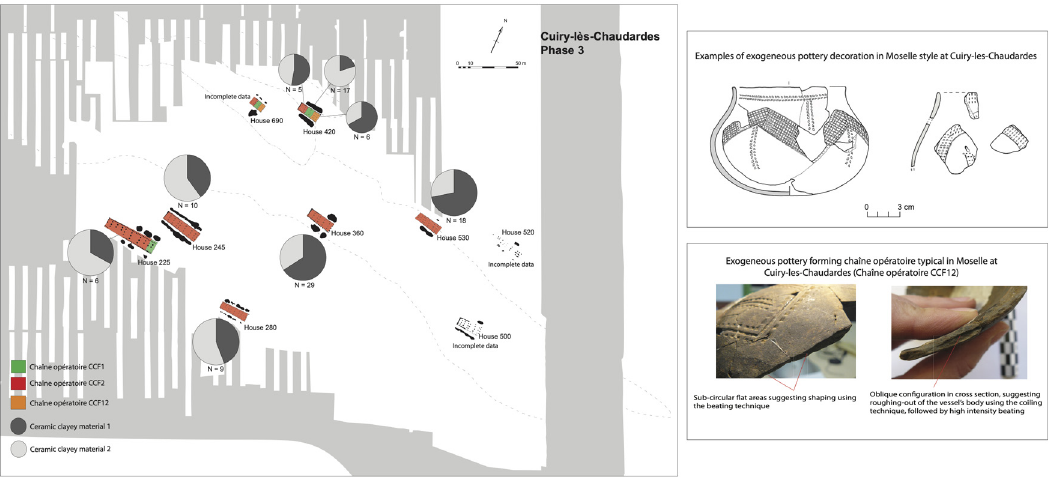
Figure 4: Spatial distribution of the two local ceramic clayey materials at Cuiry - lès - Chaudardes during the third occupational phase and examples of exogeneous pottery decoration and forming chaîne opératoire that are typical in the Moselle